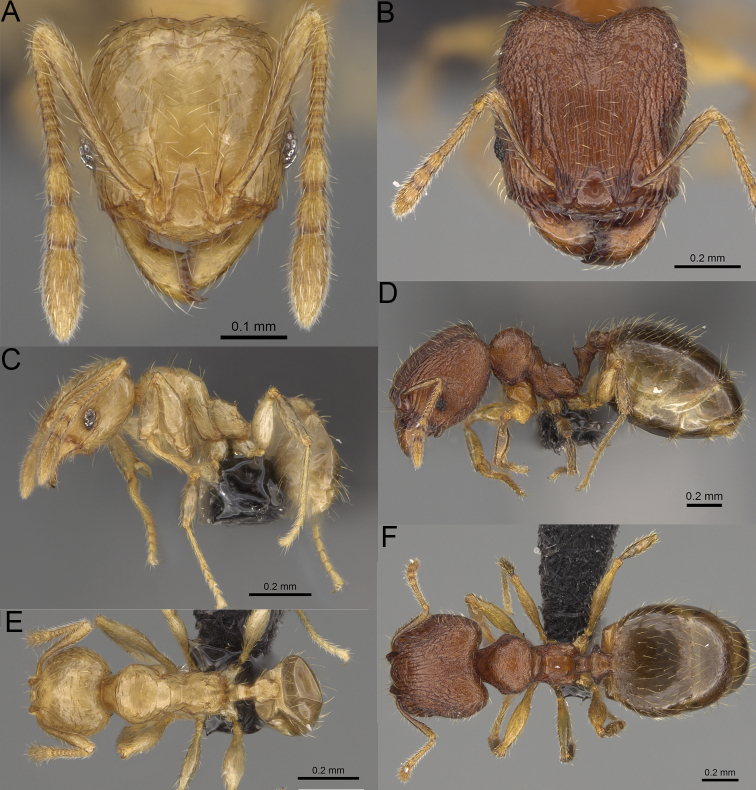
Pheidole
beanka sp. nov., full-face view (A), profile (C), and dorsal view (E) of paratype minor worker (CASENT0923276) and full-face view (B), profile (D), and dorsal view (F) of holotype major worker (CASENT0156684).